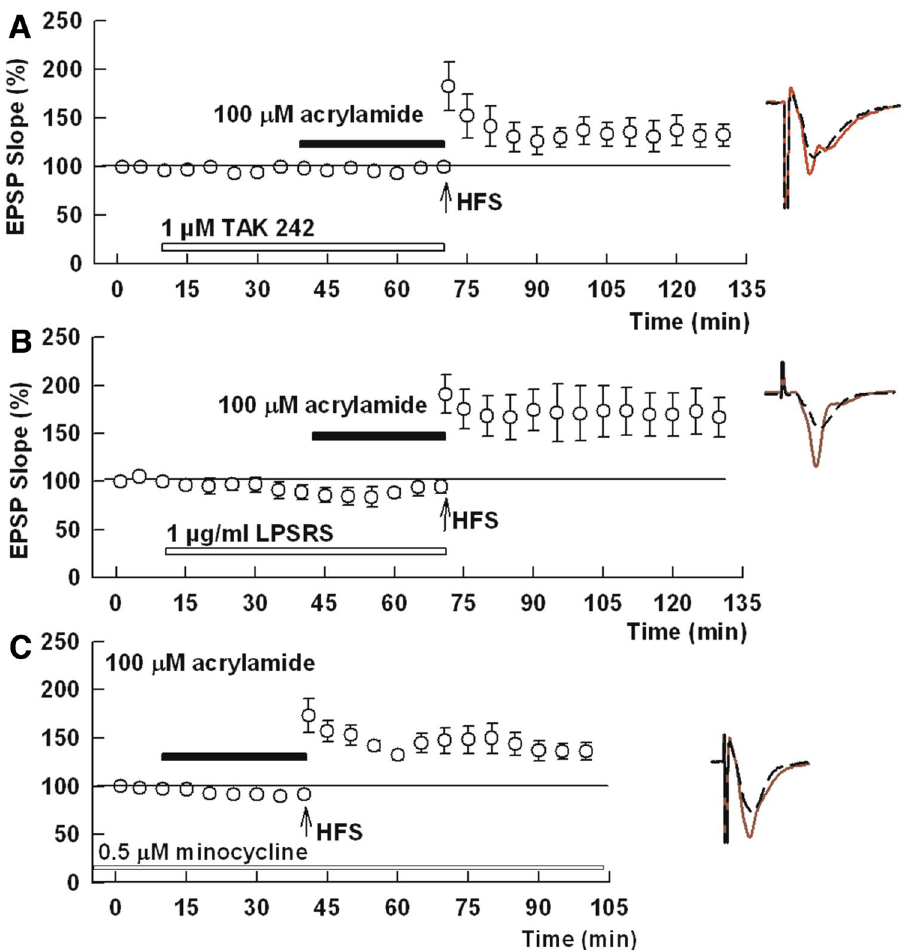
Figure 4. TLR4 antagonists and minocycline overcome effects of ACR on LTP. ( A ) TAK 242 (white bar), a TLR4 antagonist, allows LTP induction after HFS (arrow) in spite of the presence of 100 µM ACR (black bar). ( B ) Similarly, LPSRS (white bar), another TLR4 antagonist, overcomes inhibitory effects of 100 µM ACR on LTP induction. ( C ) At 0.5 µM, the microglial inhibitor, minocycline (white bar) also overcomes the inhibitory effects of ACR (black bar) on LTP. Traces show representative EPSPs. Calibration: 1 mV, 5